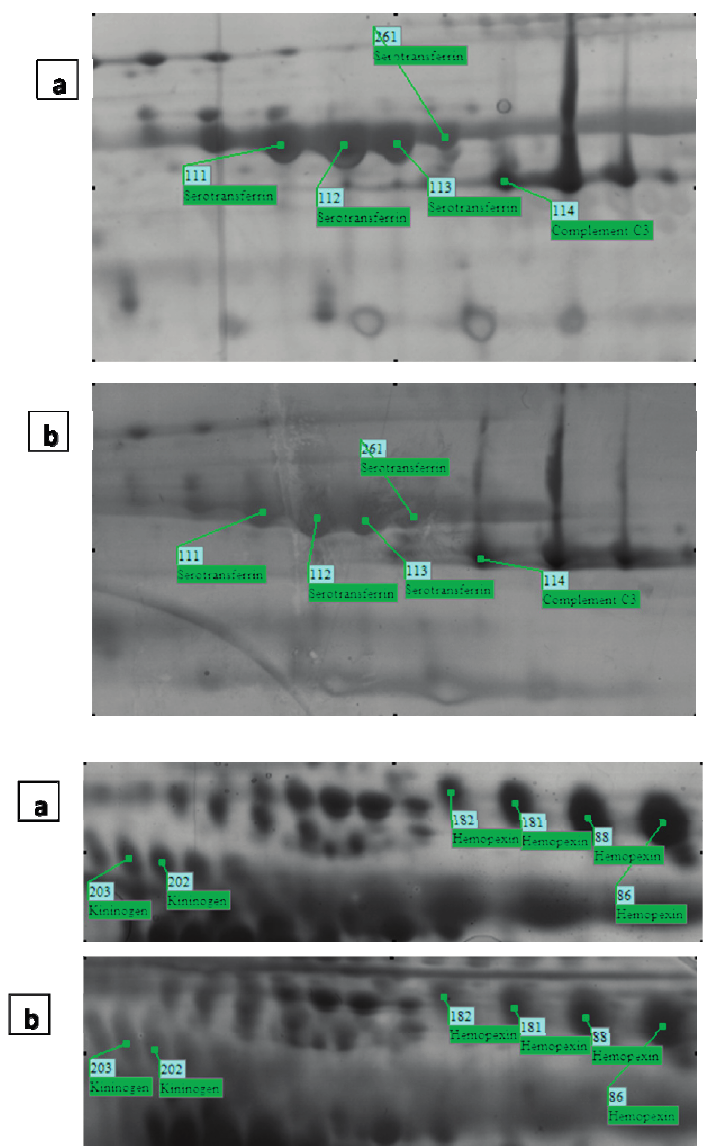
Figure 3. Magnified 2-DE maps of representative spots with differential expression between the young group ( a ) and the aged group ( b